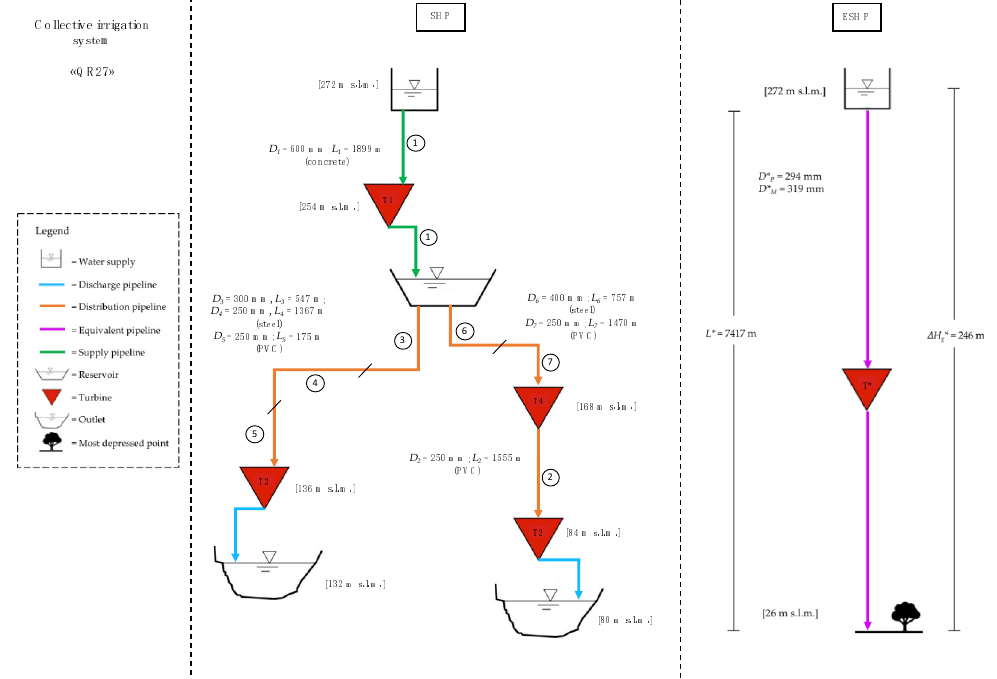
Figure 3. Schemes of small hydro power (SHP) and equivalent small hydro power (ESHP) plants in the “QR27” irrigation system (Calabria, Southern Italy).